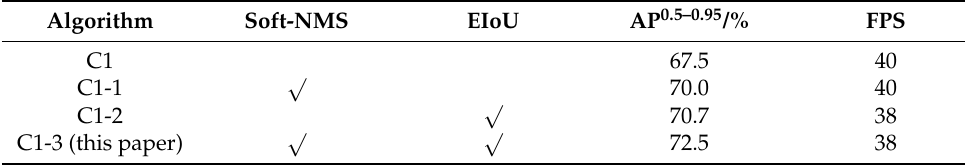
Table 3. Ablation experiment.